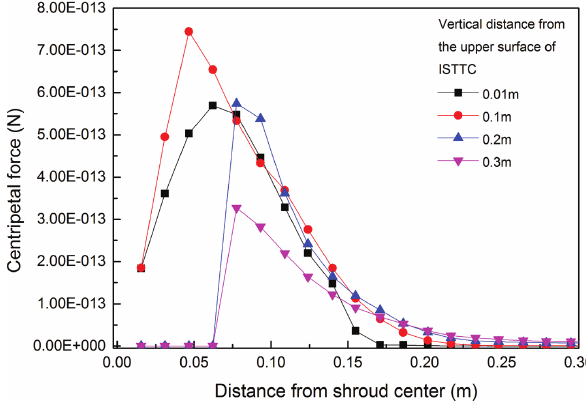
Figure 12: The centripetal force applied to inclusion in swirling flow formed from ISTTC ( θ =